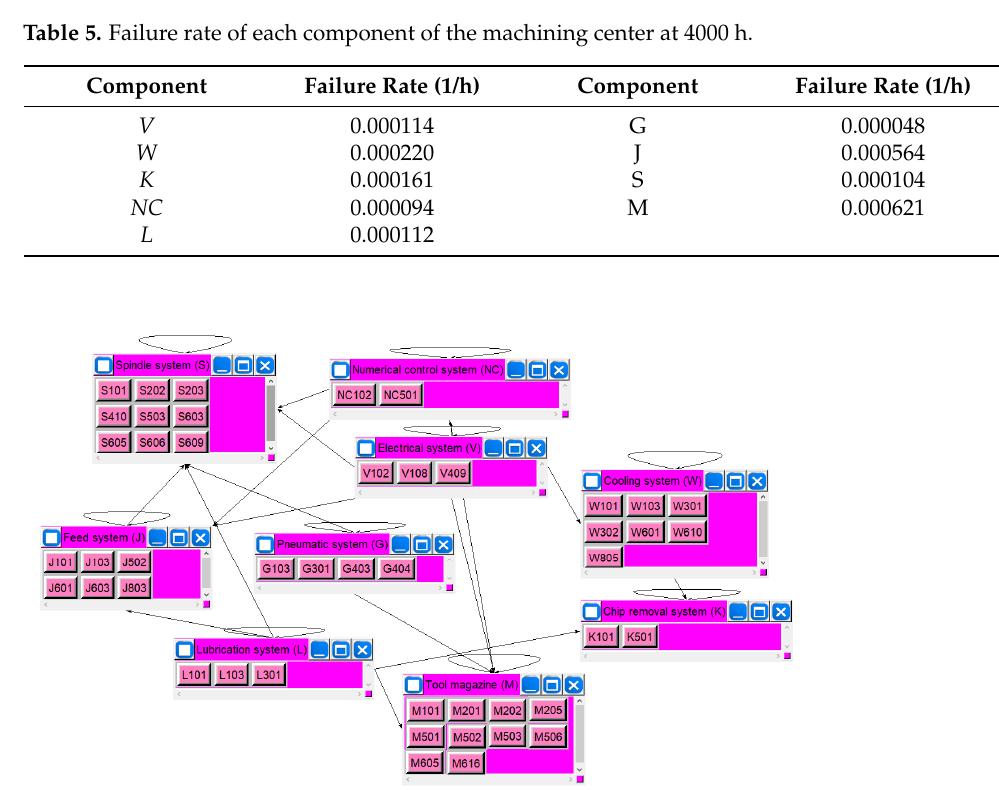
Table 5. Failure rate of each component of the machining center at 4000 h.